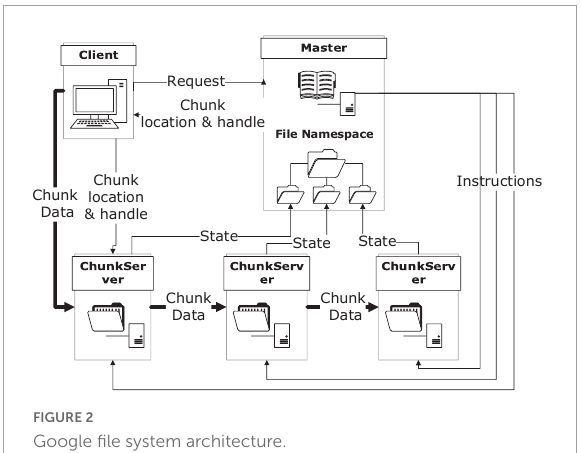
FIGURE2 Google file system